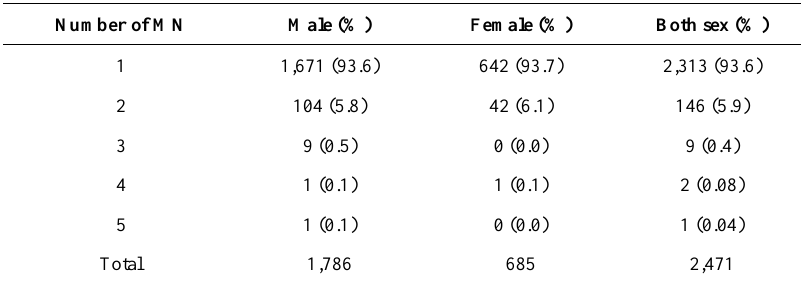
Table 2. The number of MN in the study